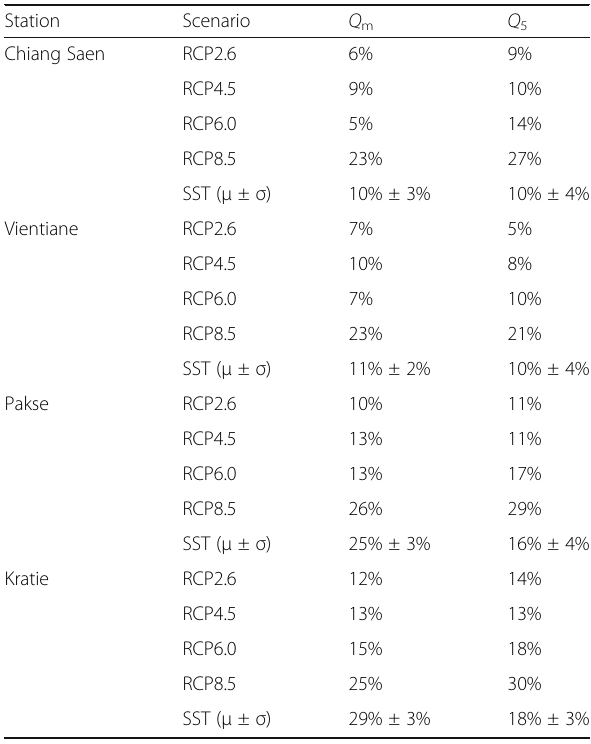
Table 3 Changes (%) of annual mean discharge ( Q m ) and flow exceeded 5% of the time ( Q 5 ) for each RCP and SST scenarios comparing with present climate. The values for SST scenarios show mean ( μ ) ± standard deviation ( σ